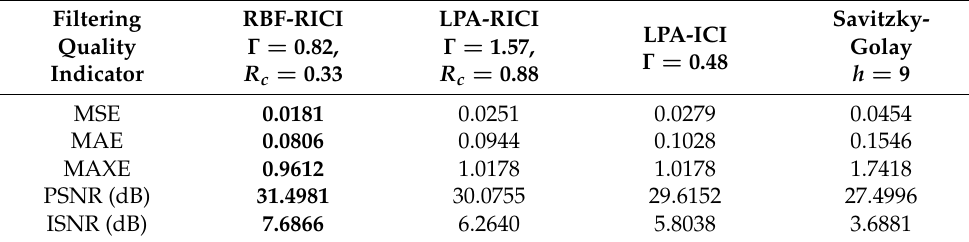
Table 9. Bumps signal (SNR = 7 dB)—Filtering results.